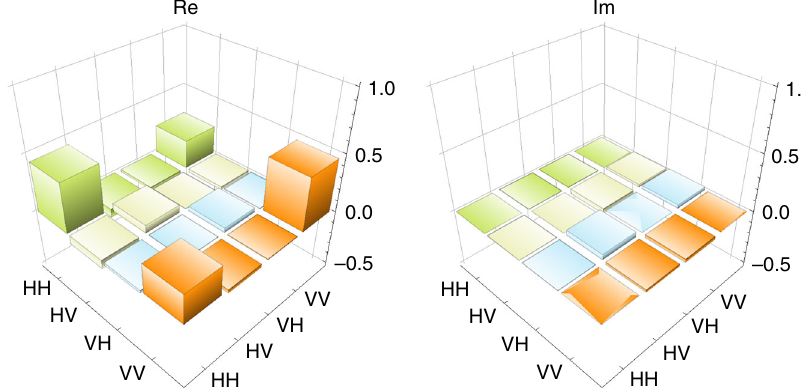
ρ U θ , respectively S ; ASt 1 1